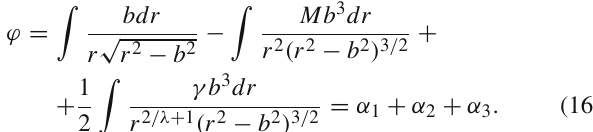
The deflection angle can be found using the